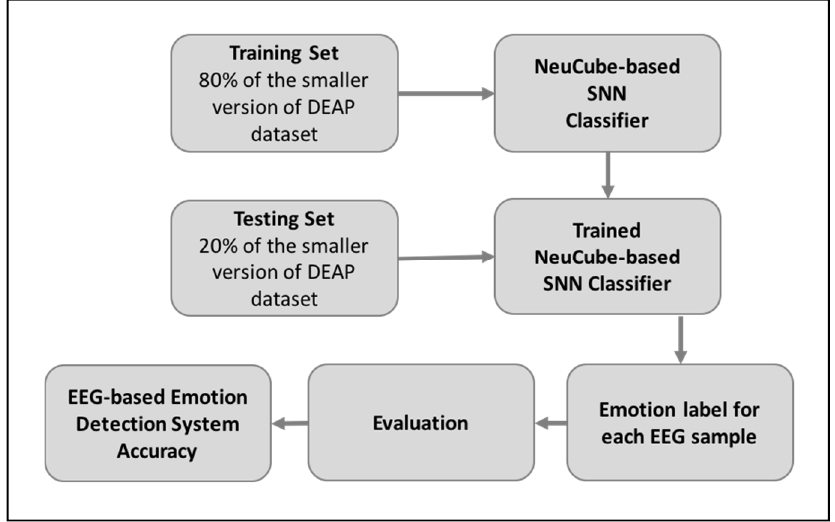
Figure 5. The proposed solution.